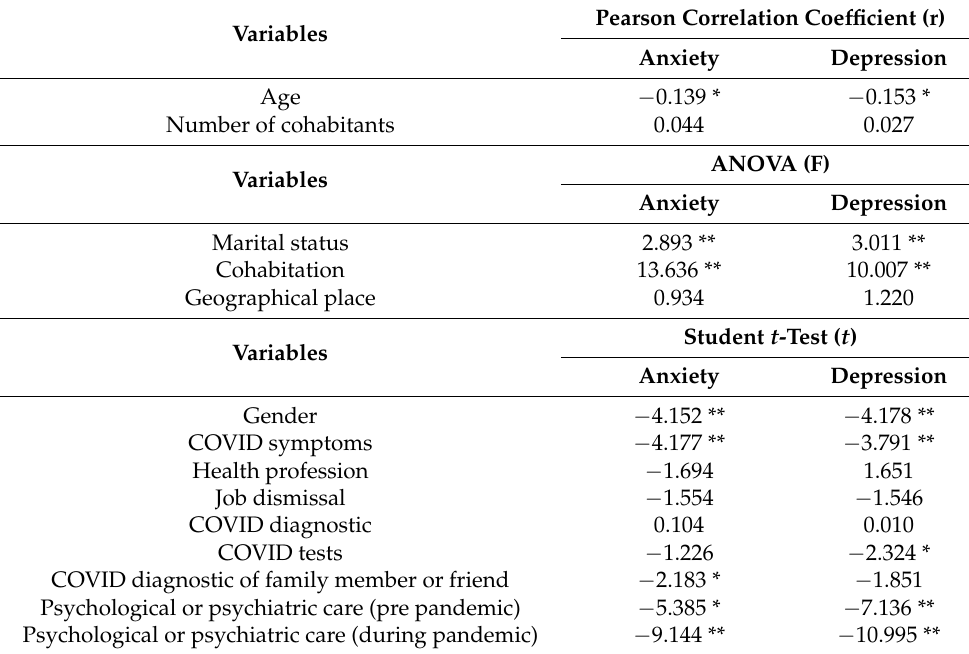
Table 4. Inferential analysis between variables and scale GADS † ( N = 808), Spain,